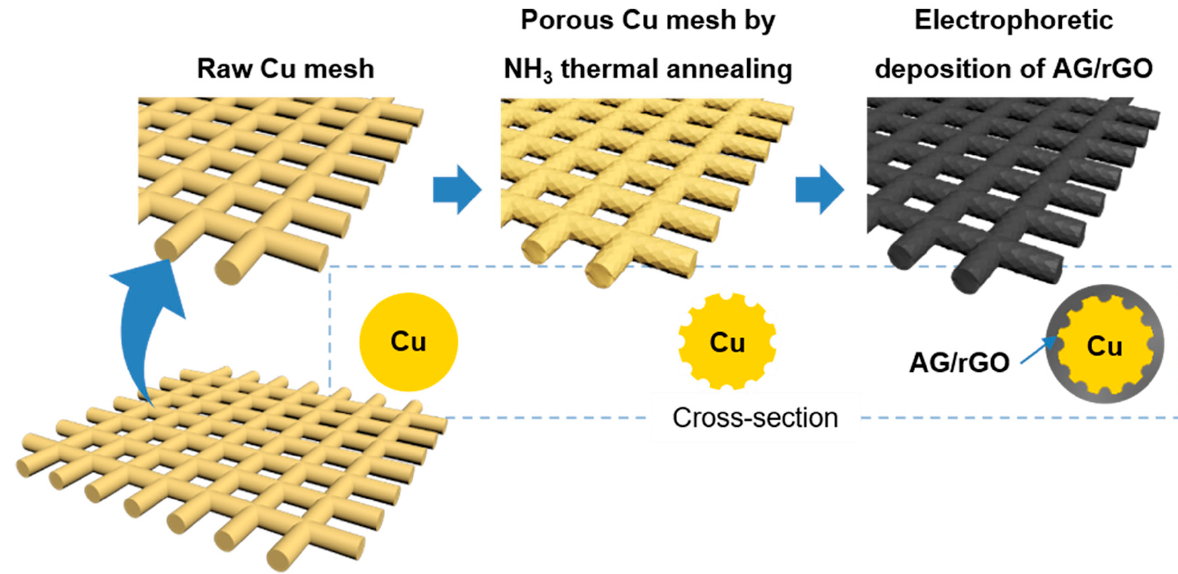
Figure 1. Schematic illustration of the fabrication of activated graphene (AG)/reduced graphene oxide (rGO) deposited on a porous Cu (P-Cu) mesh.